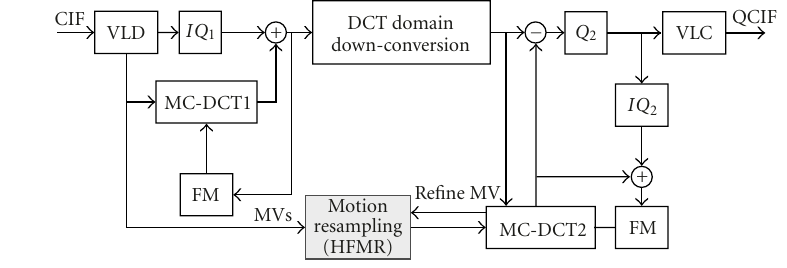
Figure 10: Using FRNI in CDDT.